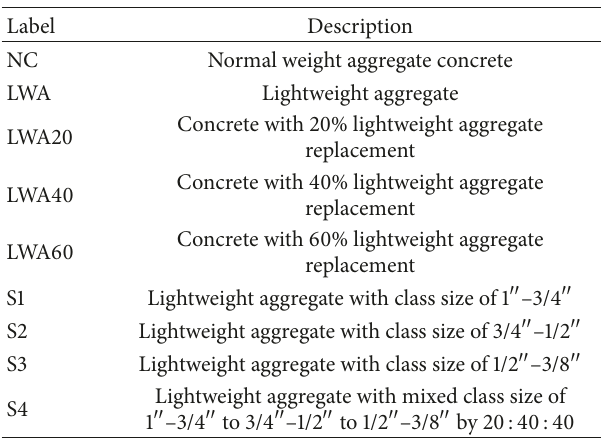
Table 2: Mixture labels and